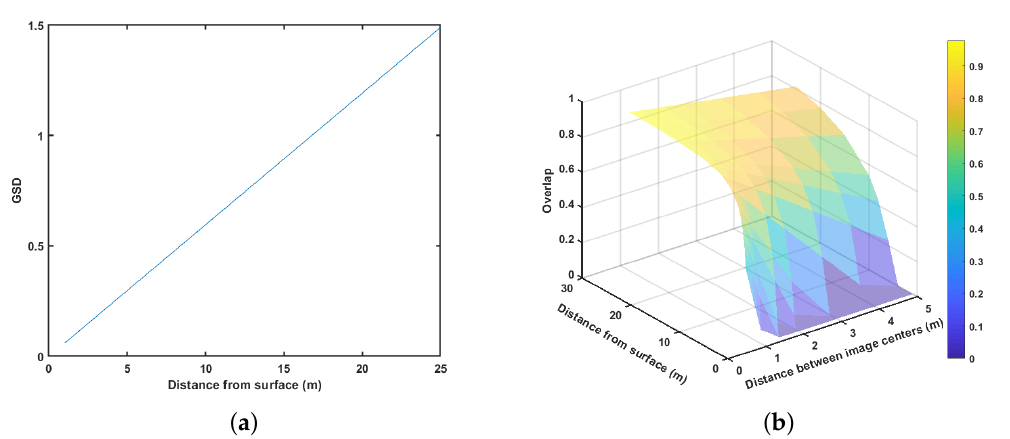
Figure 6. DJI Phantom 4 camera quality in relation to the waypoint parameters. ( a ) GSD vs. distance. ( b ) Overlap in relation to distance of surface and distance between image centers.